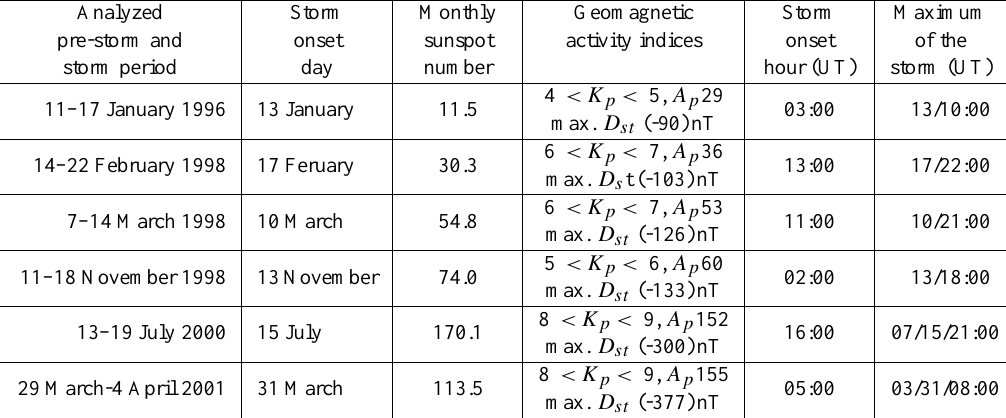
Table 1. The analyzed geomagnetic storms Analyzed Storm Monthly Geomagnetic Storm Maximum pre-storm and onset sunspot activity indices onset of the storm period day number hour (UT) storm (UT) 4 <K p < 5, A p 13 January 11.5